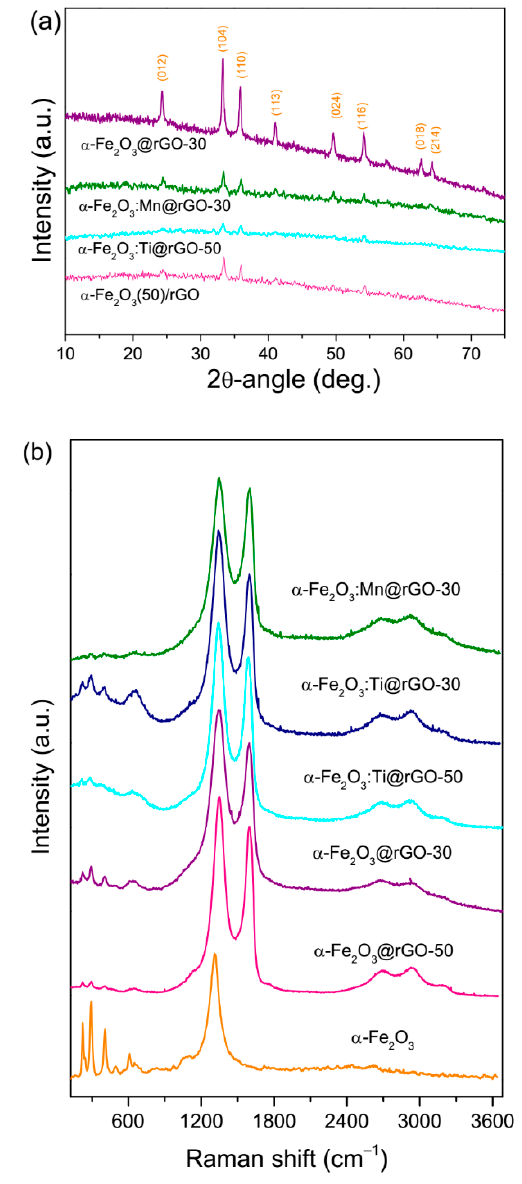
Figure 2. ( a ) XRPD patterns and ( b ) Micro-Raman spectra of the nanocomposites. The micro-Raman spectrum of the unsupported α -Fe 2 O 3 nanoparticles, previously synthesized by the same method [75], is reported for comparison purposes.